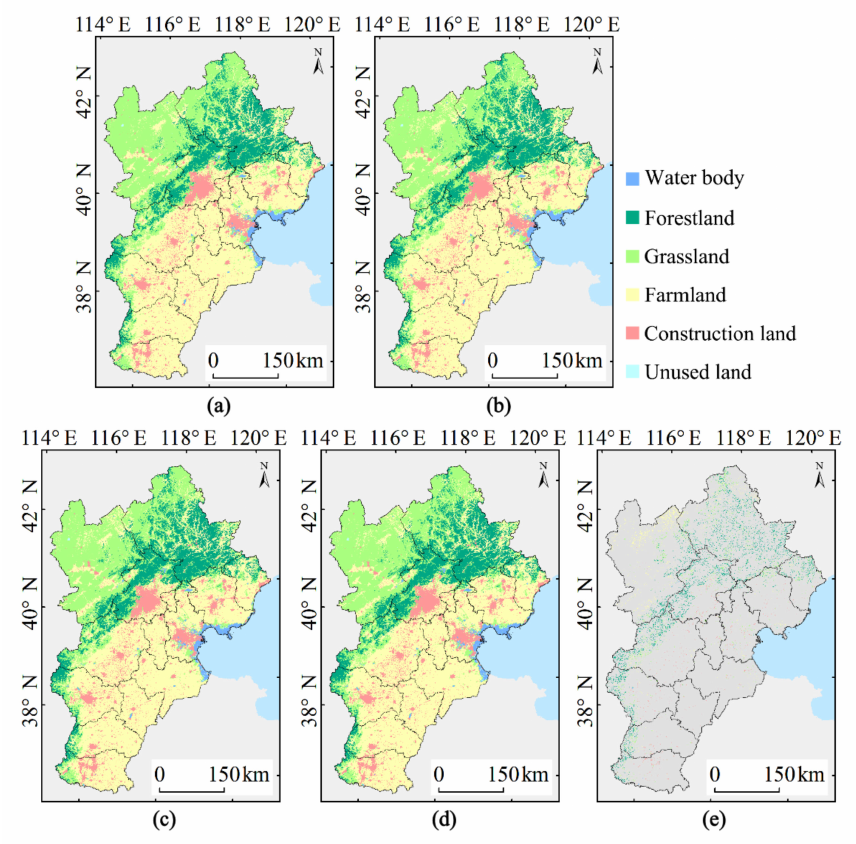
Figure 4. Spatial distributions of land use in 2015 ( a ), 2016 ( b ), 2017 ( c ), and 2018 ( d ) and a schematic representation of the land use changes that occurred ( e